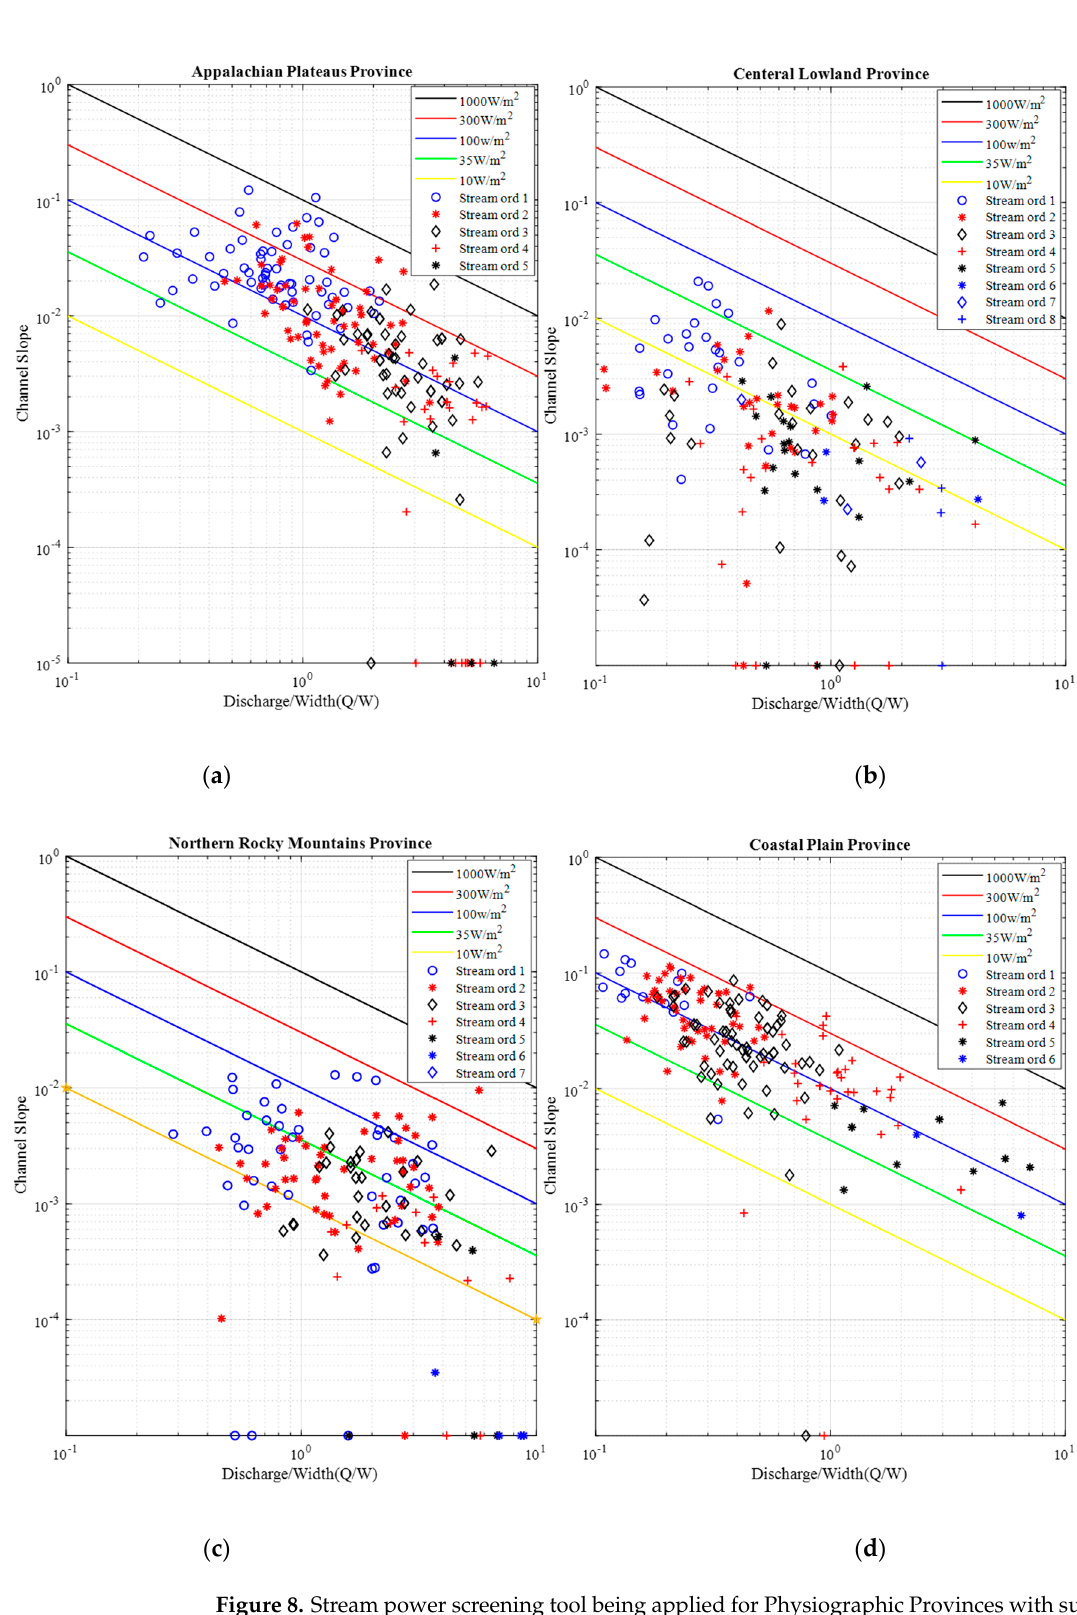
Figure 8. Stream power screening tool being applied for Physiographic Provinces with superimposed lines indicating stream power values. Data points were arranged and plotted on a stream order basis ( a ) Appalachian Plateaus ( b ) Central Lowland ( c ) Northern Rocky Mountains ( d ) Coastal Plains.